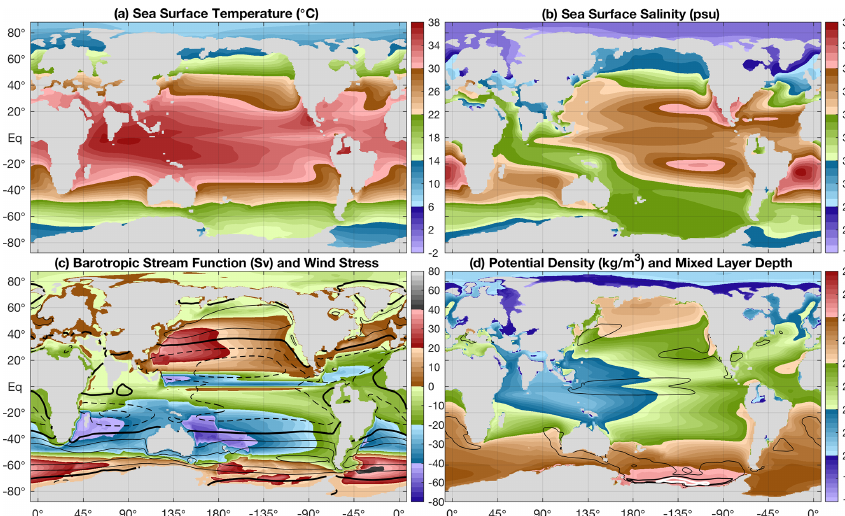
Figure 3. Annual mean for the 38Ma 4 × PIC simulation with (a) sea surface temperature and (b) salinity, (c) barotropic stream function (positive for clockwise flow) and zonal wind stress (contours every 4 × 10 − 2 Pa, solid positive and dashed negative, thick line at 0Pa), and (d) upper 200m average potential density and mixed layer depth (contours at 100 and 250m, thick white line at 500m).